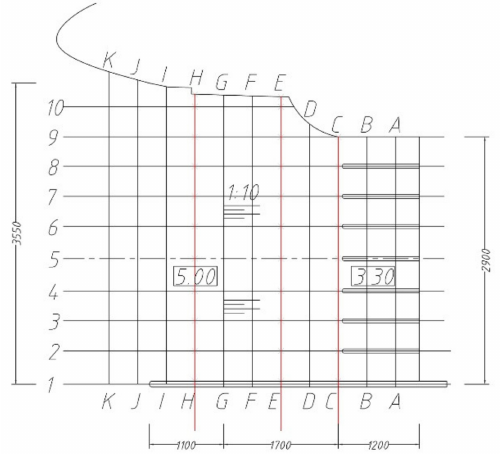
Figure 6. Diagram of line arrangement.